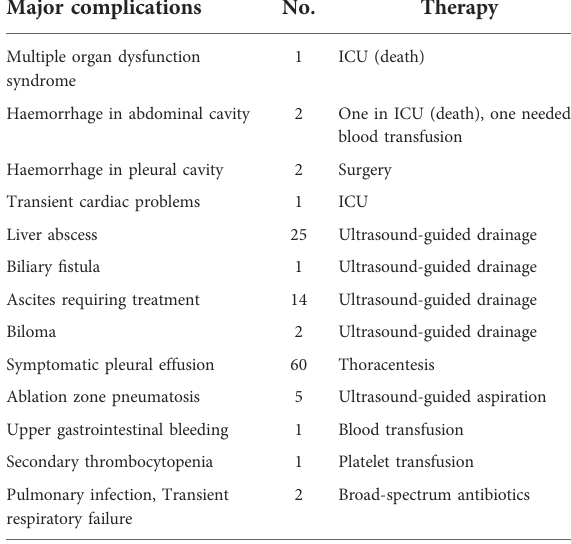
TABLE 2 Major complications after 2,084 thermal ablation sessions. TABLE 1 Baseline characteristics of 1,592 patients in 2,084 ablation